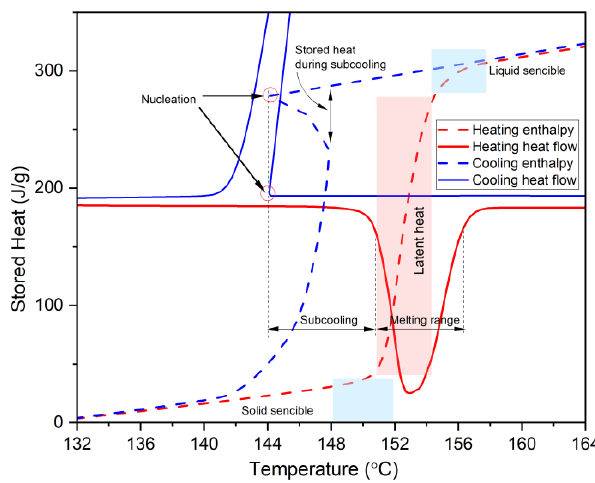
Figure 7. PCMs representing stored heat as a function of temperature during the melting phase and solidification with subcooling (personal data for adipic acid).